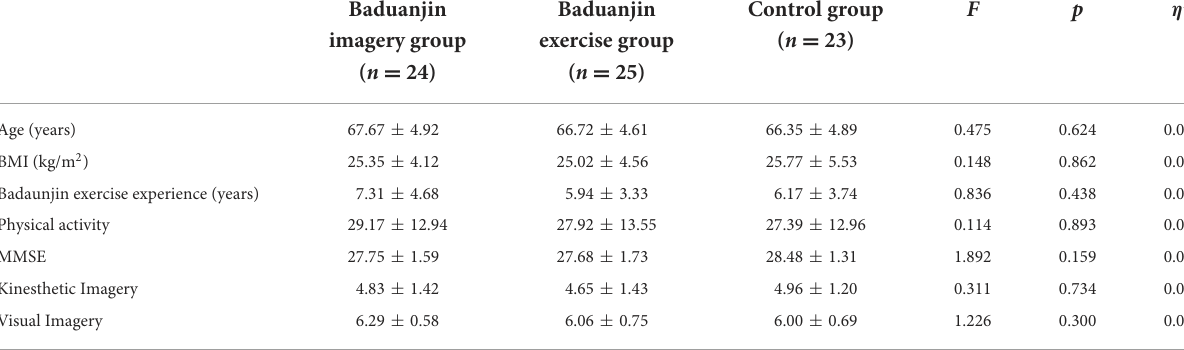
TABLE 2 Group differences in demographic indicators, MMSE, PARS-3, and MIQ-R (M ±